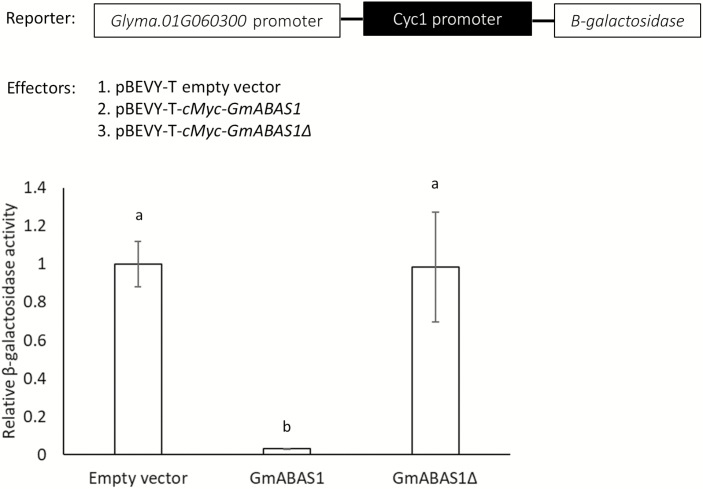
Yeast promoter-binding reporter assay showing the binding of GmABAS1 to the promoter of Glyma.01G060300 and the transcriptional repressor activity of GmABAS1. The sequence 3 kb upstream of the translational start of Glyma.01G060300 was cloned upstream of the LacZ gene in pLacZi. This construct was used as the reporter. The effectors were pBEVY-T empty vector, pBEVY-T-cMyc-GmABAS1, or pBEVY-T-cMyc-GmABAS1Δ, respectively. The yeast strain W303α was co-transformed with the reporter and the effector plasmids. The β-galactosidase assay was done using the overnight culture of yeast grown at 28 °C in SD-Trp-Ura medium (with 2% fructose). The β-galactosidase activity was detected at 420 nm using a microplate reader (SpectraMax Plus 384 Microplate Reader, Molecular Devices). The absorbance at 420 nm was normalized with the cell density as determined by the absorbance at 600 nm. The β-galactosidase activities of yeast cells carrying both pLacZi without the promoter of Glyma.01G060300 and either empty pBEVY-T, pBEVY-T-cMyc-GmABAS1, or pBEVY-T-cMyc-GmABAS1Δ served as the control for basal signals. The β-galactosidase activities of yeast cells carrying both pLacZi containing the promoter of Glyma.01G060300 and either empty pBEVY-T, pBEVY-T-cMyc-GmABAS1, or pBEVY-T-cMyc-GmABAS1Δ were then normalized to their respective basal signals. Each error bar represents the SE of three technical repeats. Each lower case letter above the bar indicates a statistically distinct group with P<0.05 based on one-way ANOVA followed by Tukey HSD test. The experiment was performed twice with similar results.